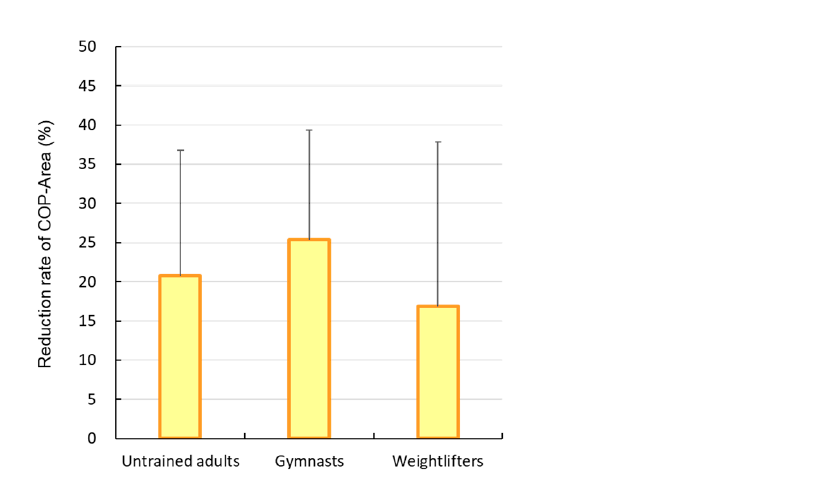
Figure 9. Comparison of the reduction rate of area enclosed by the trajectory of the center of pressure fluctuation (COP-Area) among participant groups when wearing mouthguards. Measurements are expressed as means ± SD. Error bar indicates standard error of the mean.